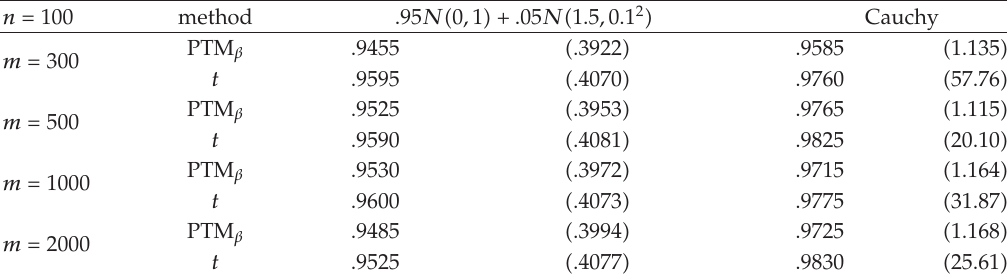
Table 2: Average coverage (cid:2) length (cid:3) of 95% CIs by t and PTM β